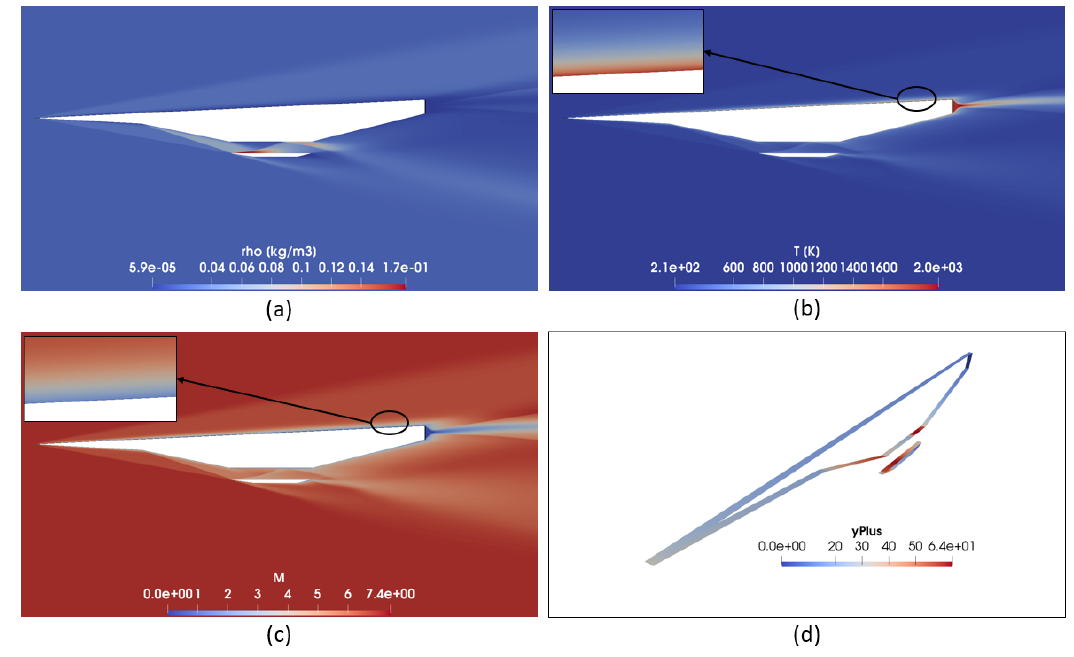
Figure 11. Density field ( a ), temperature field ( b ), Mach field ( c ) and y + distribution along the walls ( d ) of case 1 for AoA = 0 ◦